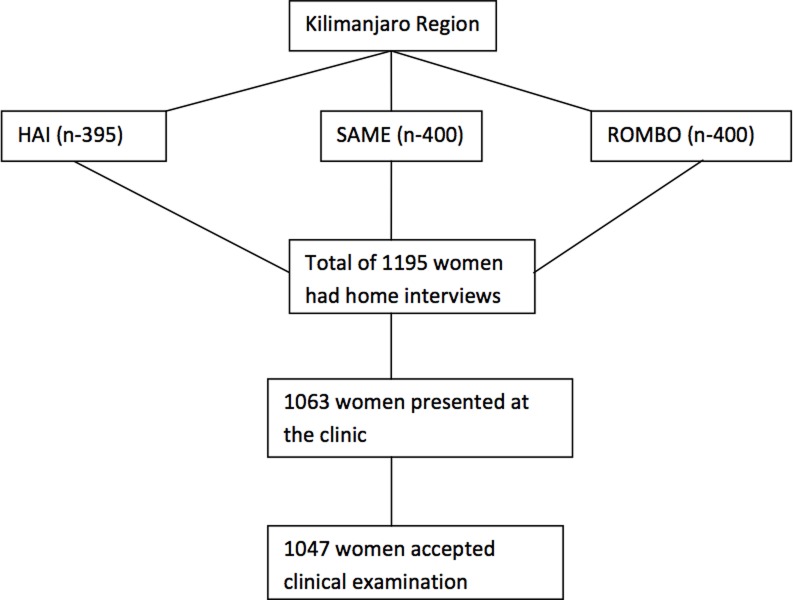
Study flowchart.